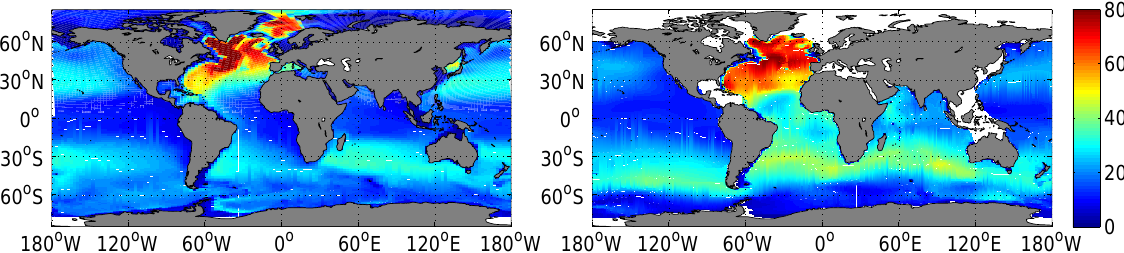
Fig. 2. Map of column integrated anthropogenic carbon content in the ocean for the year 1994 simulated by the BCM-C (left) and compared to the observation-based estimates (right) from Sabine et al. (2004). Units are in [molCm − 2